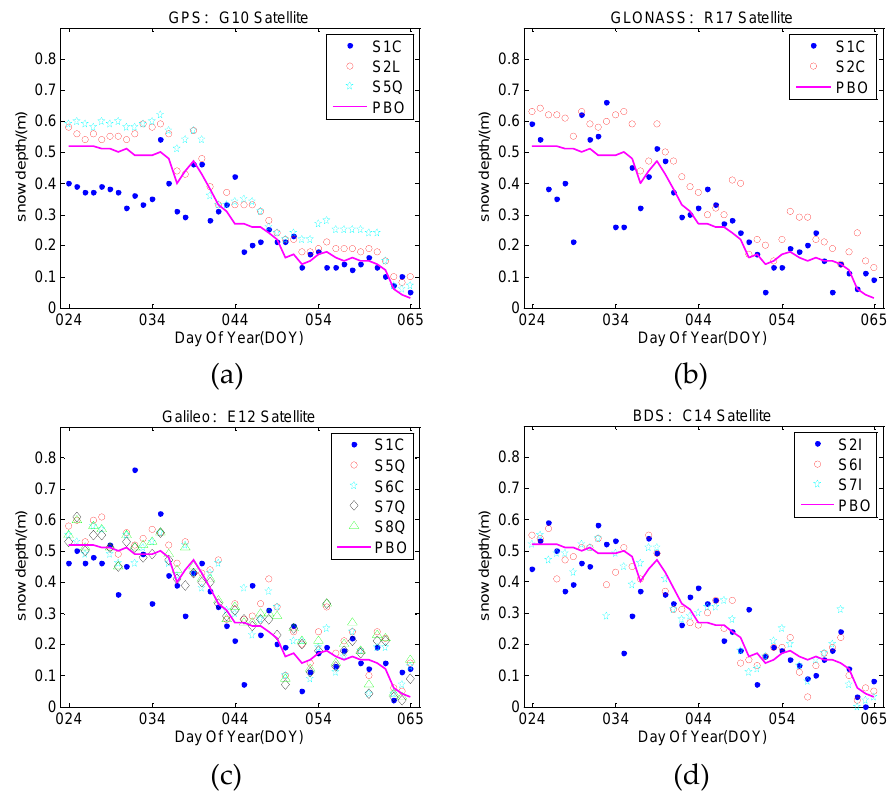
Figure 11. Comparison between multi-GNSS and multi-frequency GNSS-IR snow depth retrieval results and PBO snow depth: ( a ) GPS snow depth retrieval results; ( b ) GLONASS snow depth retrieval results; ( c ) Galileo snow depth retrieval results; ( d ) BDS snow depth retrieval results.